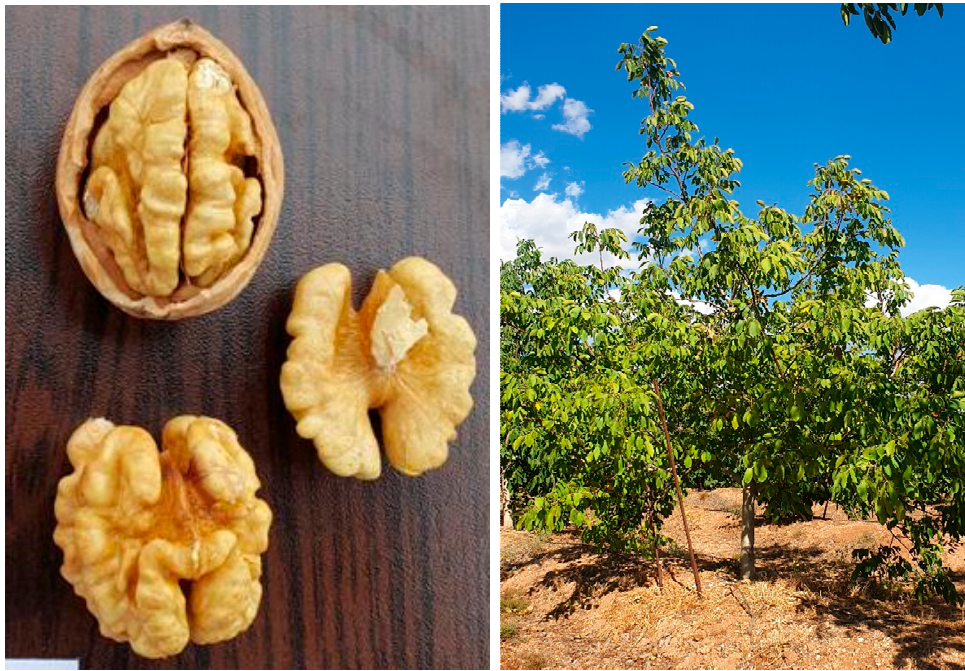
Figure 4. An overview of nuts, kernels, and the tree of ‘Helete Güne ş i’.